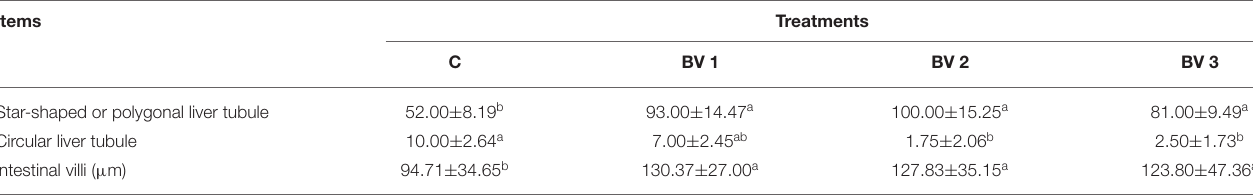
Star-shaped or polygonal liver tubule